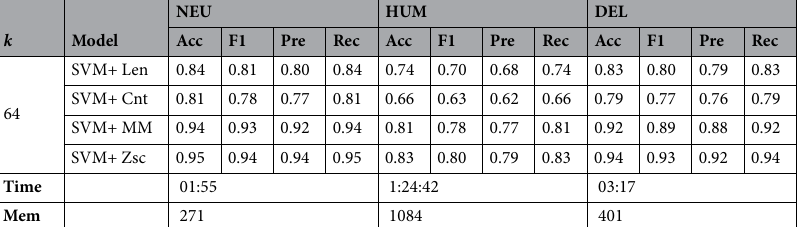
including Alzheimer’s disease and Parkinson’s disease. In contrast, trinucleotide repeat units, such as TAA, TAG, and TGA, are favored during premature termination codon mutations and are also involved in some neurologi- cal diseases, including Alzheimer’s disease. This suggests that the proposed metric has the potential to identify patterns that may be genetic features in a sample of neurological genes. Moreover, the practical performance and high prediction results of the statistically significant STR-based feature set indicate that variations in STR enrichment patterns can distinguish neurological disease genes. This is a conclusion drawn from a computer